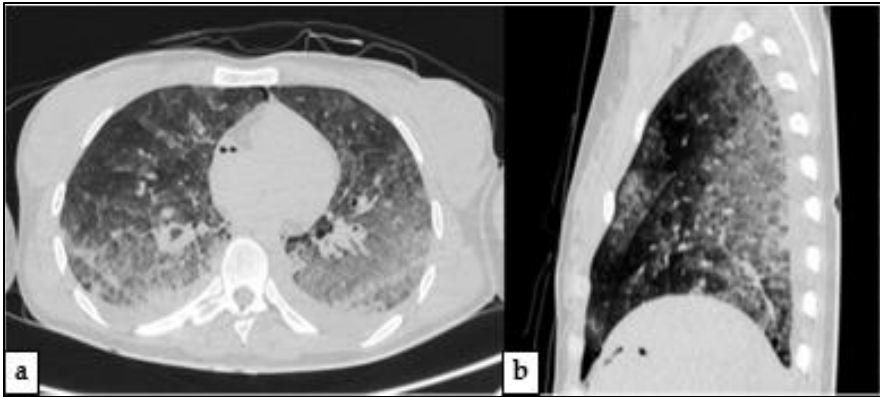
Figure 2. – PMCT of Chest — ( a ) Axial image revealed high attenuation areas, mainly ground glass, with a gradient appearance (in dependent regions). ( b ) Sagittal view of chest shows that almost only dorsal aspects of lungs are affected by opacity alterations.